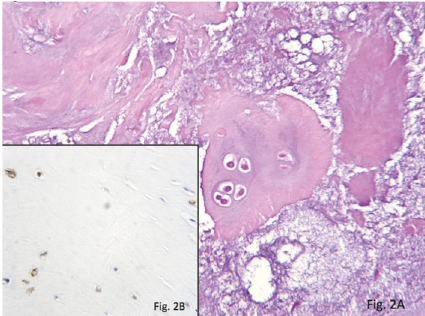
Figure 2: (A) In the tumour, mature chondrocyte nests are found in a basophilic chondroid matrix with myxoid loose areas. (B) In the lower left corner of the image, positive immunostaining for S-100 is seen in the cytoplasm and nucleus of chondrocyte-like cells